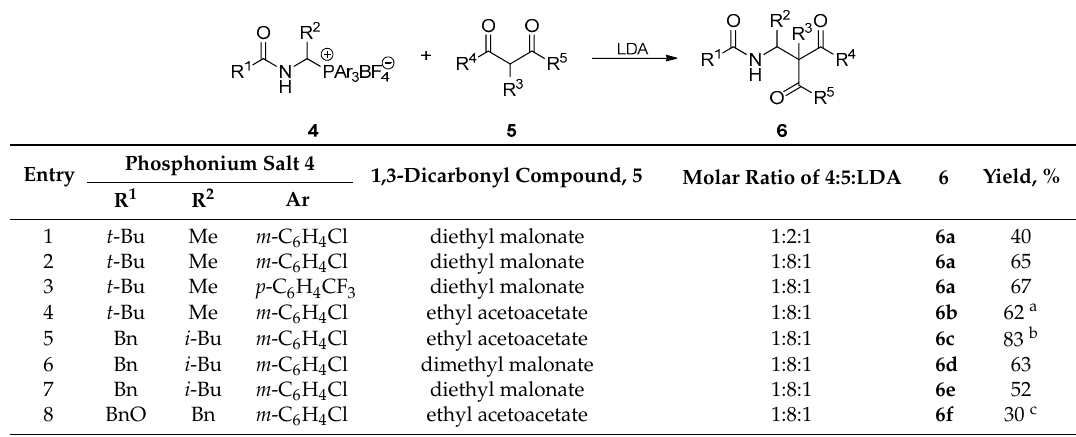
Table 1. Conditions and yields for α -amidoalkylation of 1,3-dicarbonyl compounds by 1-( N -acylamino)alkyltriarylphosphonium salts 4 .